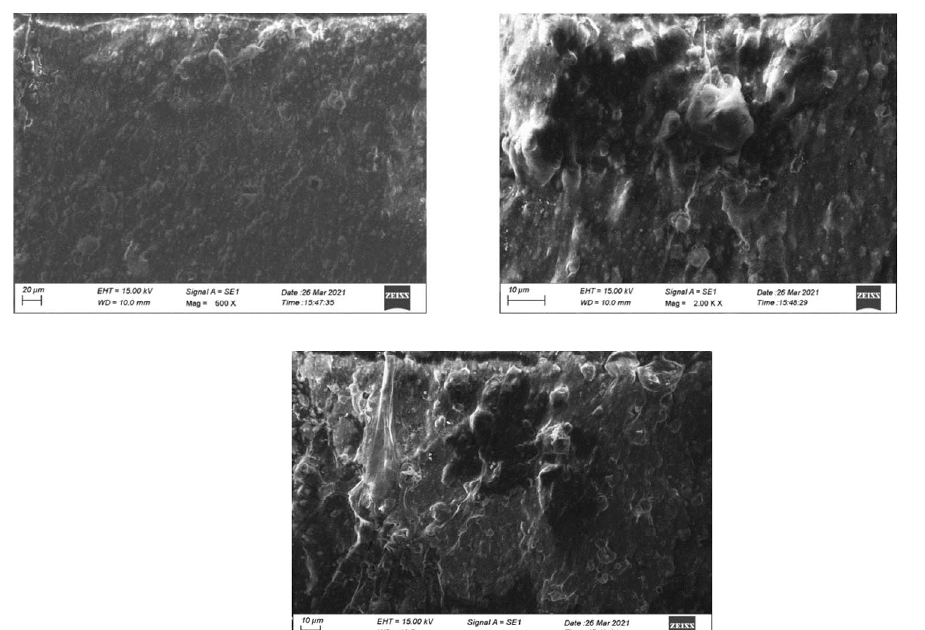
Fig. 8. Shows the surface degradation of the PU sheet in